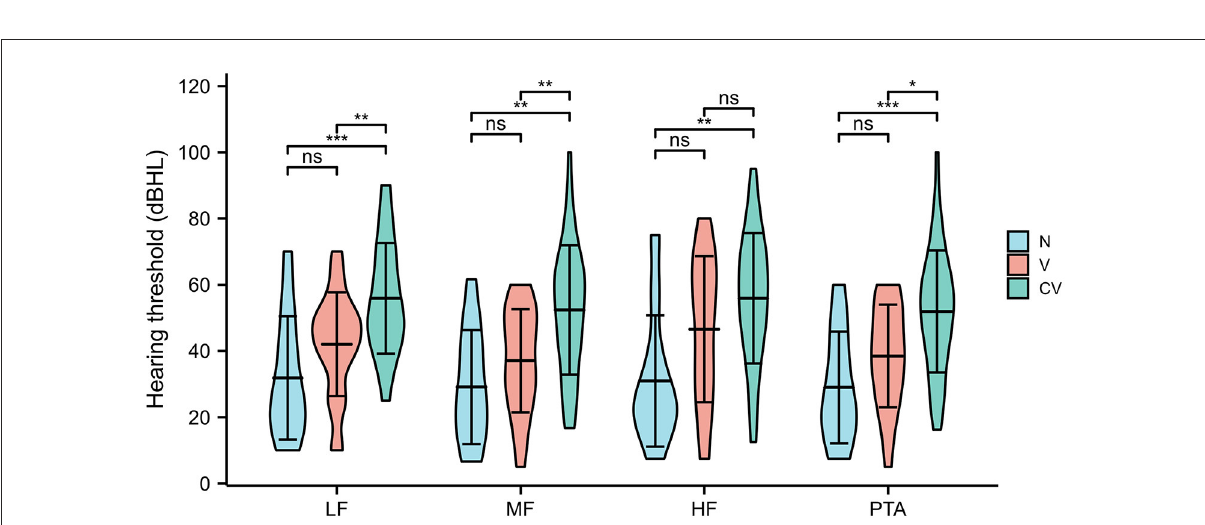
FIGURE4 Relationship between different types of hydrops and hearing thresholds at each frequency in Ménière’s patients. LF, Low Frequency, MF, Medium Frequency, HF, High Frequency, N, no endolymphatic hydrops, V only vestibular region with endolymphatic hydrops, CV cochlear and